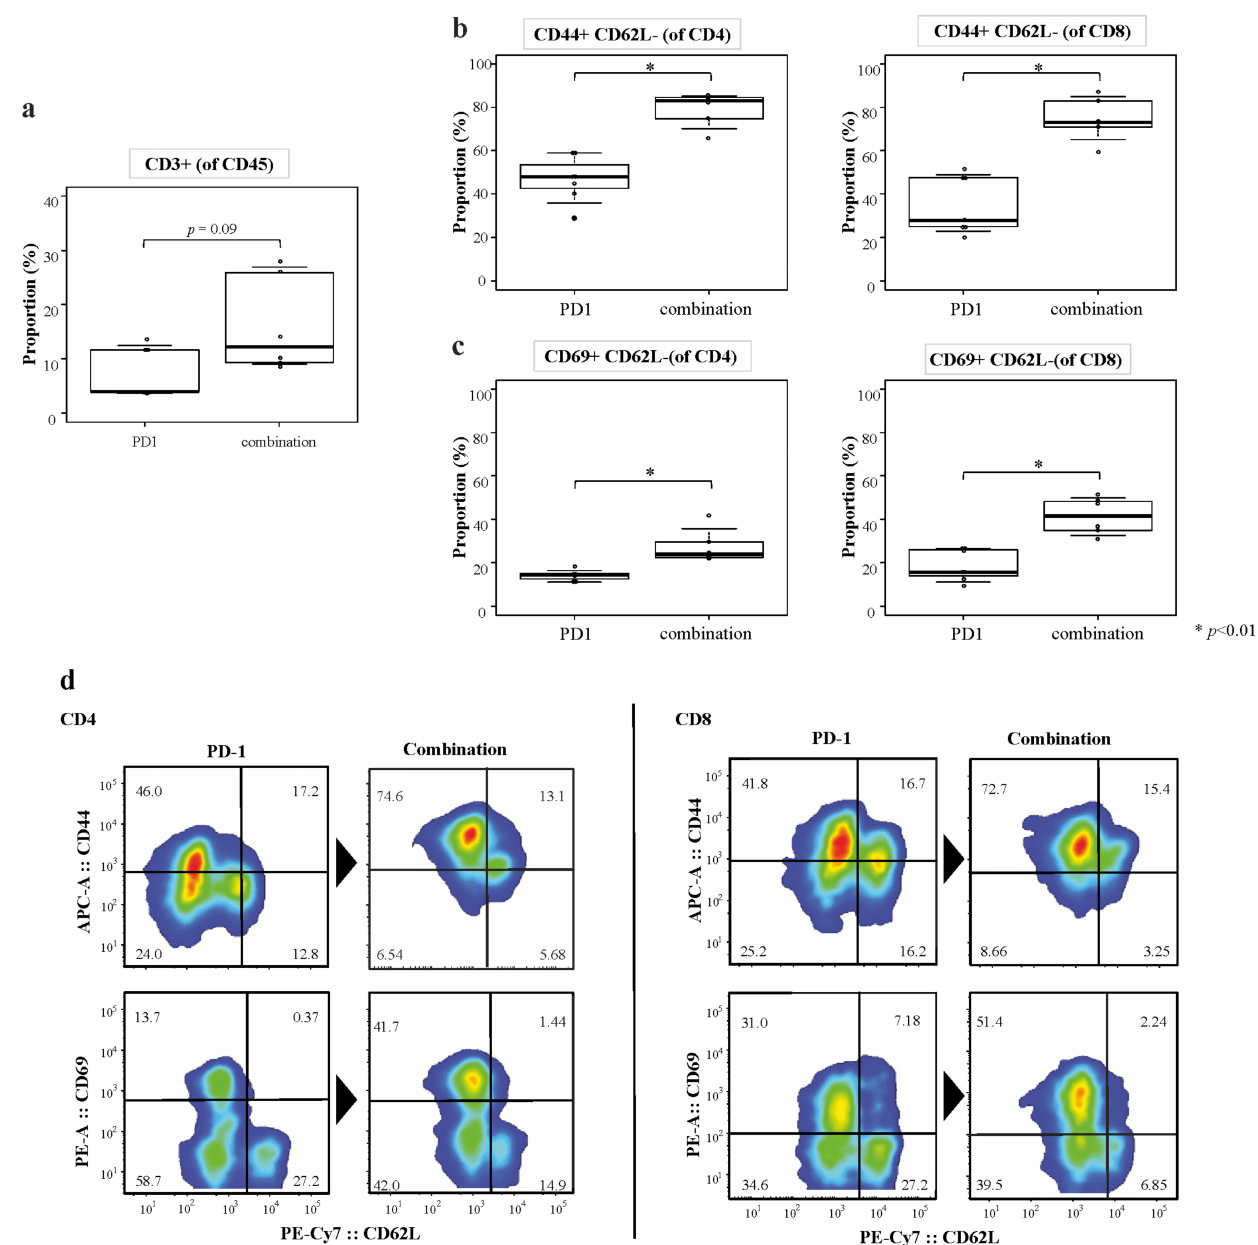
Figure 5. Fluorescence-activated cell sorting (FACS) analysis of liver metastatic tumors. FACS analysis was performed to determine the changes in the tumor immune response associated with the anti-PD-1 antibody alone or combined anti-PD-1 antibody plus dasatinib treatment. ( a ) Quantification of CD3 + cells in different experimental groups of mice. ( b ) Quantification of CD4 + CD44 + and CD8 + CD44 + cells in different experimental groups of mice. ( c ) Quantification of CD4 + CD69 + and CD8 + CD69 + cells in different experimental groups of mice. ( d ) Representative FACS graphs of CD4 + CD44 + , CD4 + CD69 + , CD8 + CD44 + , and CD8 + CD69 + cells of mice treated with the anti-PD-1 antibody alone or with a combination of anti-PD-1 antibody and